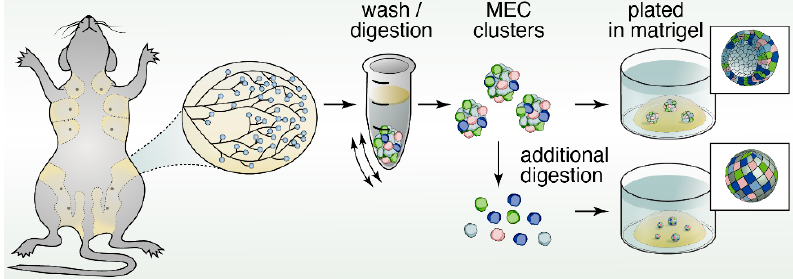
Figure 2. Schematic of three-dimensional spheroid cultures of mammary gland tissue. The discovery of Matrigel by Orkin and colleagues [26] enabled cell biological studies by many research groups with three-dimensional (3D) spheroid cultures of mammary gland tissue in vitro . Plating of digested MEC clusters aided the identification of restricted luminal- or basal-cells and bipotent progenitors in 3D, while further digestion into single mammary epithelial cells and plating into colony-forming assays provided information on the proliferative capacity.